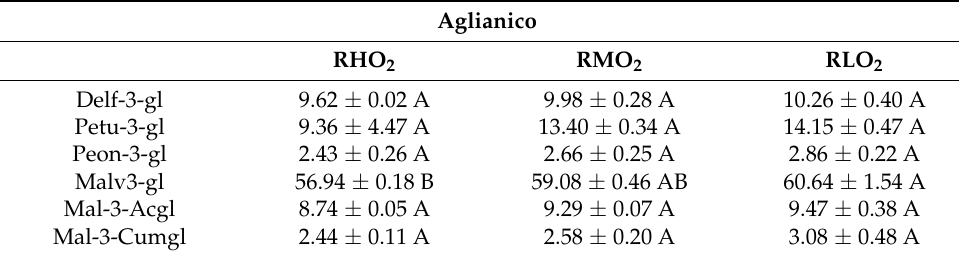
Table 3. Native anthocyanins.